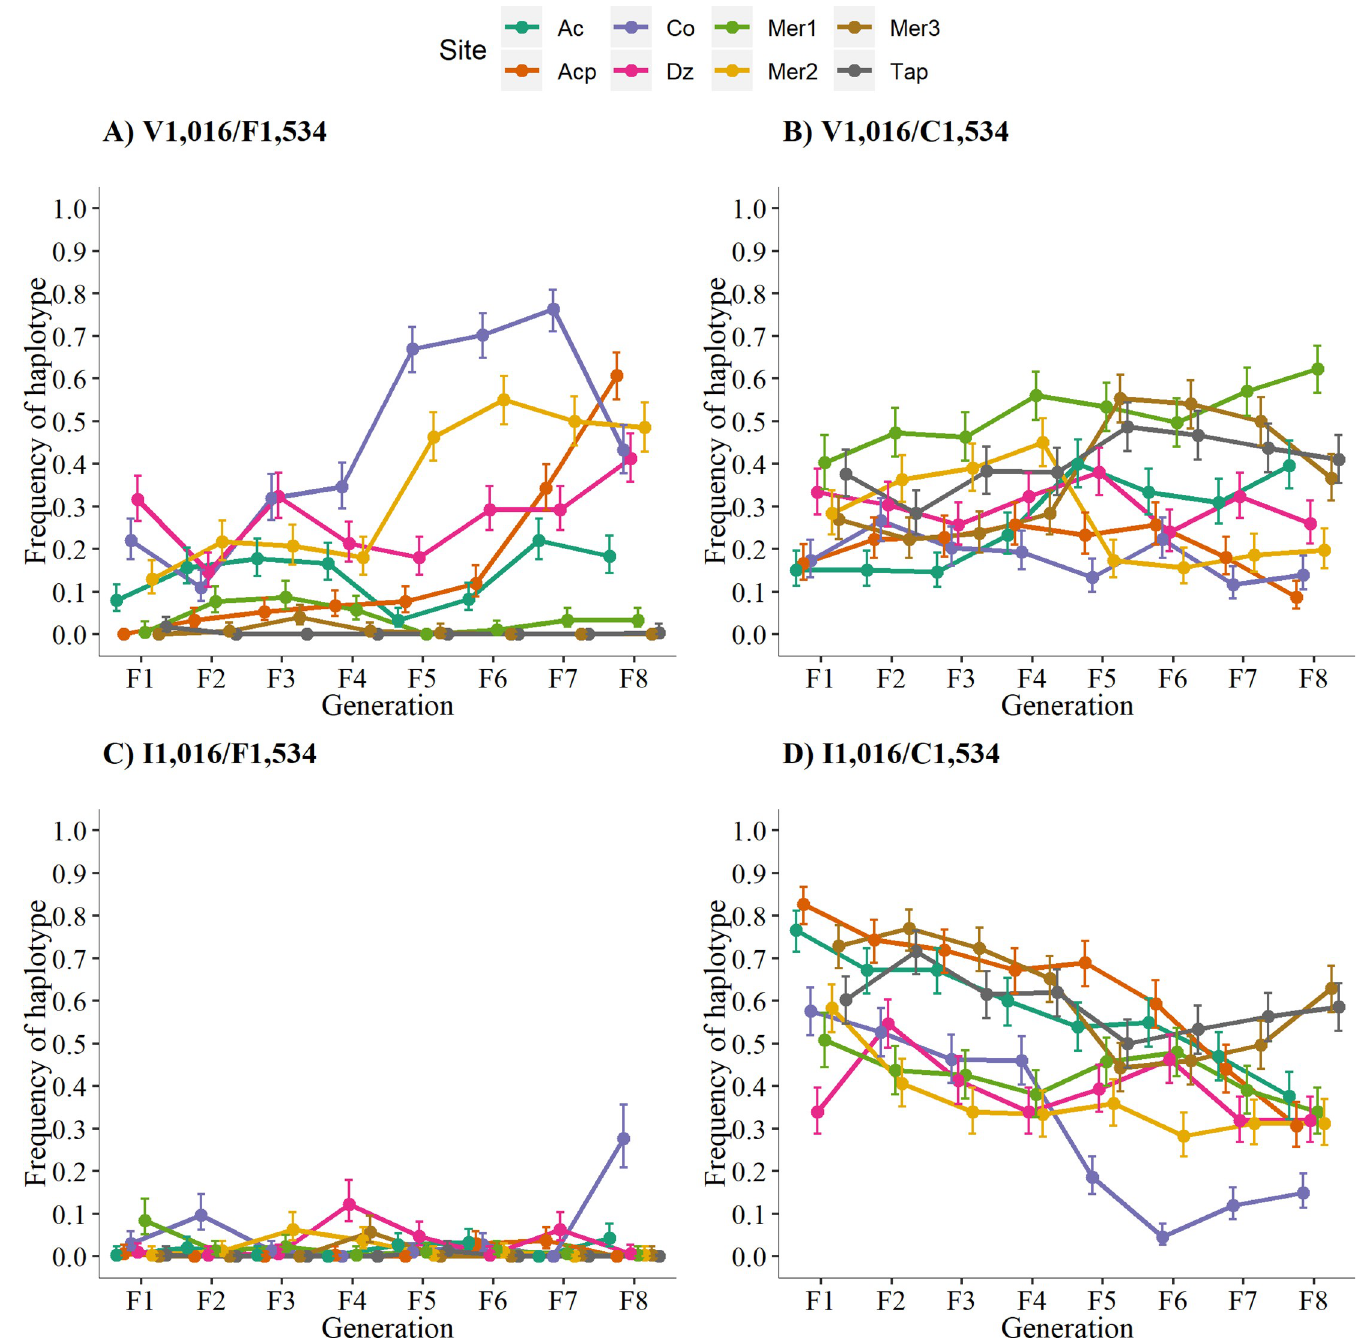
Fig 6. Frequency of the four potential di-locus haplotypes between loci V1,016I and F1,534C over eight generations in the absence of insecticides. Haplotypes: both susceptible alleles in cis = V 1,016 /F 1,534 , susceptible V 1,016 and resistant C 1,534 alleles in cis = V 1,016 /C 1,534 , resistant I 1,016 and susceptible F 1,534 alleles in cis = I 1,016 / F 1,534 , and resistant I 1,016 and resistant C 1,534 alleles in cis = I 1,016 /C 1,534